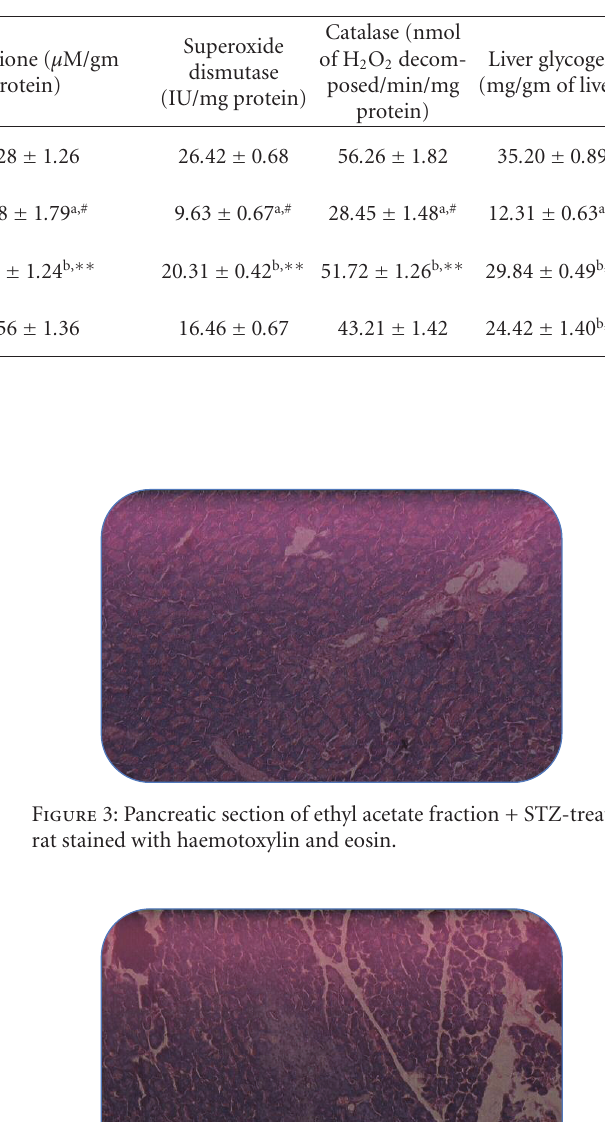
Table 4: E ff ect of ethyl acetate fraction of Stereospermum suaveolens on pancreatic lipid peroxidation, glutathione, and antioxidants in STZ-induced diabetic rats.